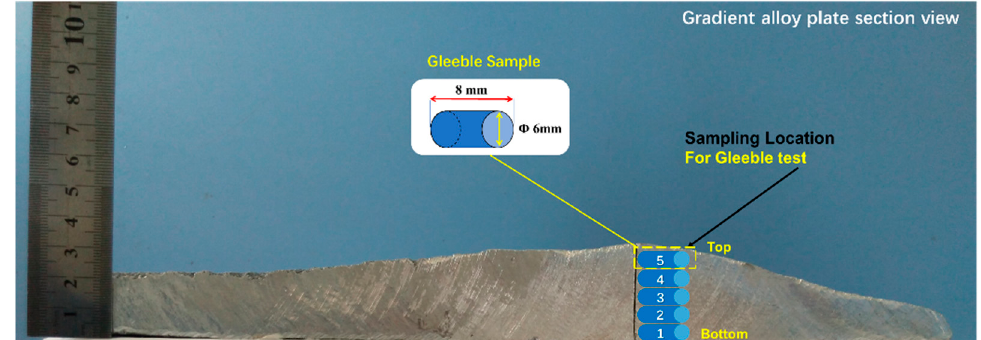
Figure 1. Schematic diagram of co-spray forming process.